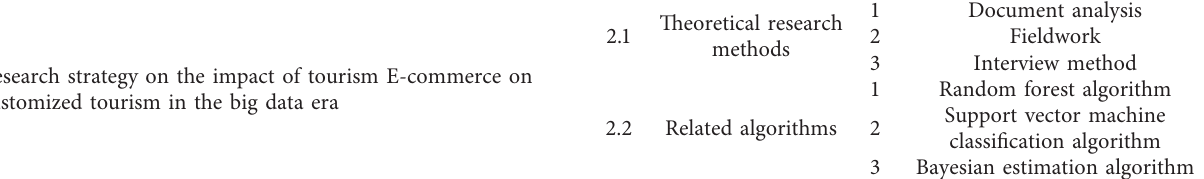
Table 1: Part of the technical process of the method in this